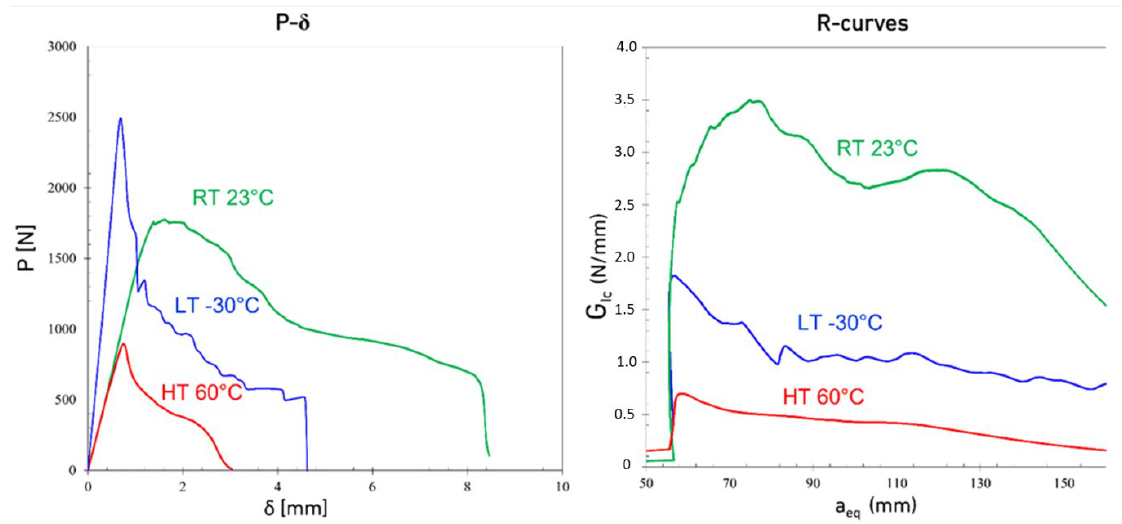
Figure 3 . Representative Load-displacement and R-curves of DCB joints under quasi-static loading rates (0.2 mm/min) at different temperatures .